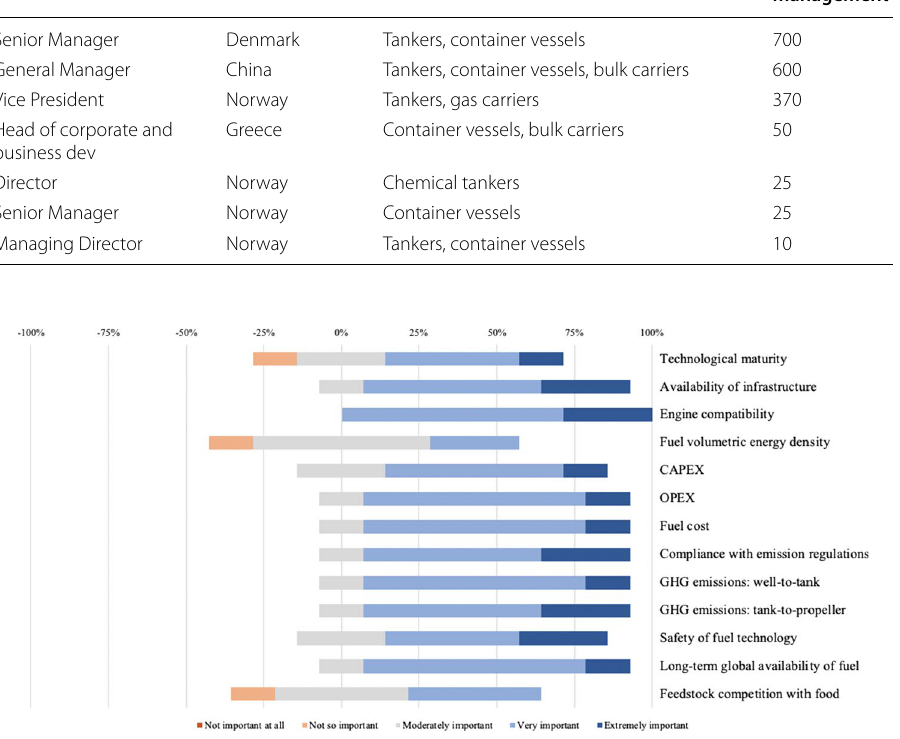
Fig. 1 Visualized survey results of evaluation